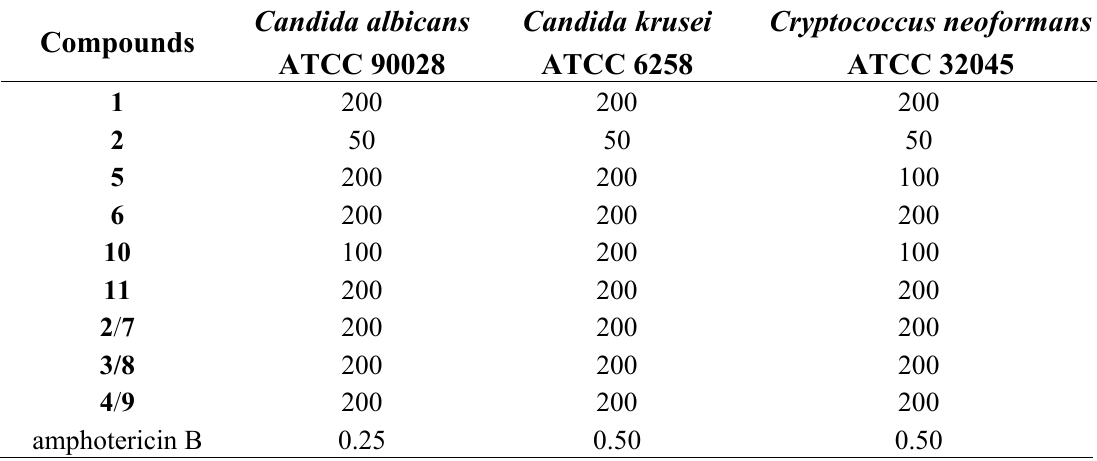
Table 1. Minimal inhibitory concentration (MIC) values ( μ g/mL) of triterpenes isolated from C. laxum against Candida and Cryptococcus strains using the microbroth dilution